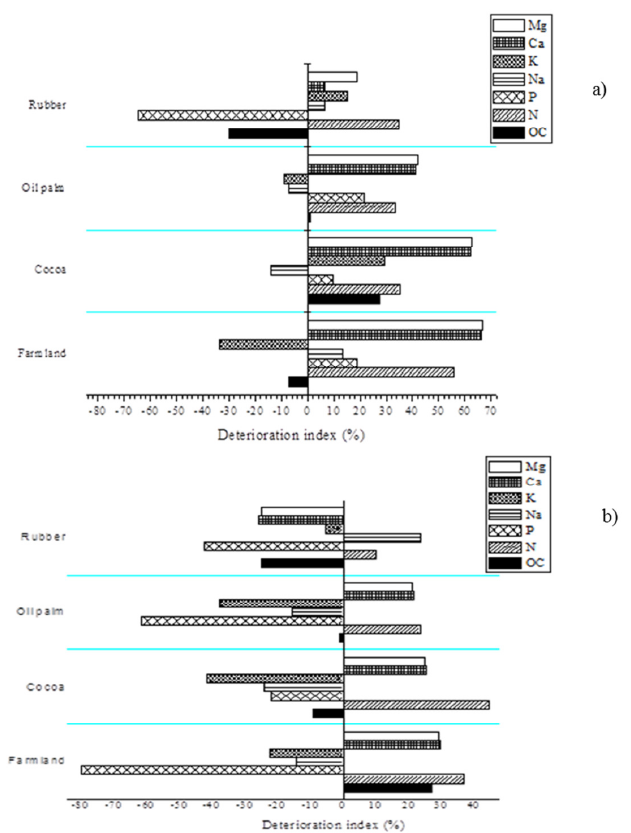
Fig. 2. Deterioration index for soil minerals from (a) top soil and (b) sub soil in four land use types in relation to a forest